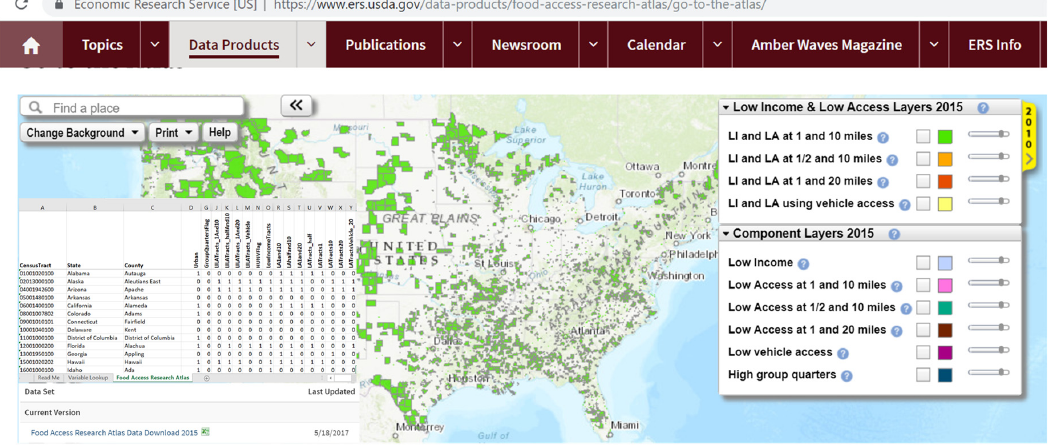
Figure 1. Data sources for constructing the 16-digit binary number encoding food access measures.